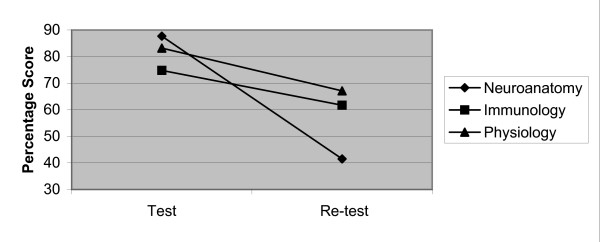
Test and Re-test scores 10 or 11 months apart for three basic science courses at the University of Saskatchewan.